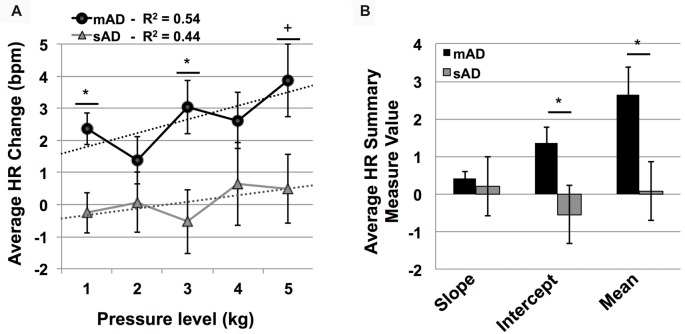
Group level autonomic pain responses (HR in beats per minute, bpm). (A) Average HR changes from baseline (bpm) for each pressure intensity (kilograms, kg) among mild Alzheimer’s (mAD; black circles) and severe Alzheimer’s (sAD; gray triangles) patient sub-groups. Associated linear regression lines are superimposed, allowing for visualization of slope of change and intercept across stimulus levels. (B) HR response summary measures across pressure levels, including slope of change, intercept and mean response. Asterisk (*) indicates significant group difference at p ≤ 0.05. Plus (+) indicates marginal significance (p < 0.06). Error bars represent SEM.